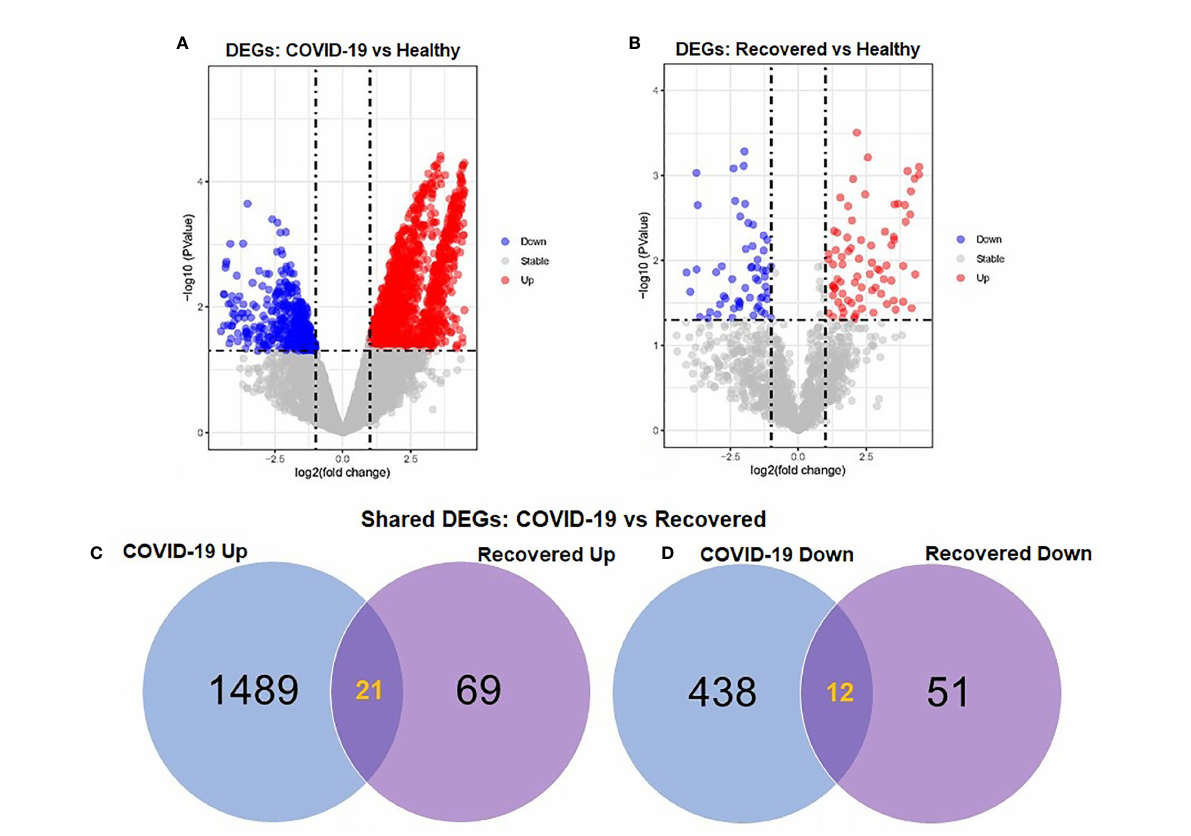
FIGURE 2 Volcano plots showing dysregulated genes in (A) COVID-19 patients vs. healthy control and (B) recovered humans vs. healthy controls. The red and blue dots indicate the expressions of the upregulated (Up) and down-regulated (Down) DEGs, respectively. Venn diagrams depict the unique and shared DEGs (C) upregulated and (D) down-regulated under the given